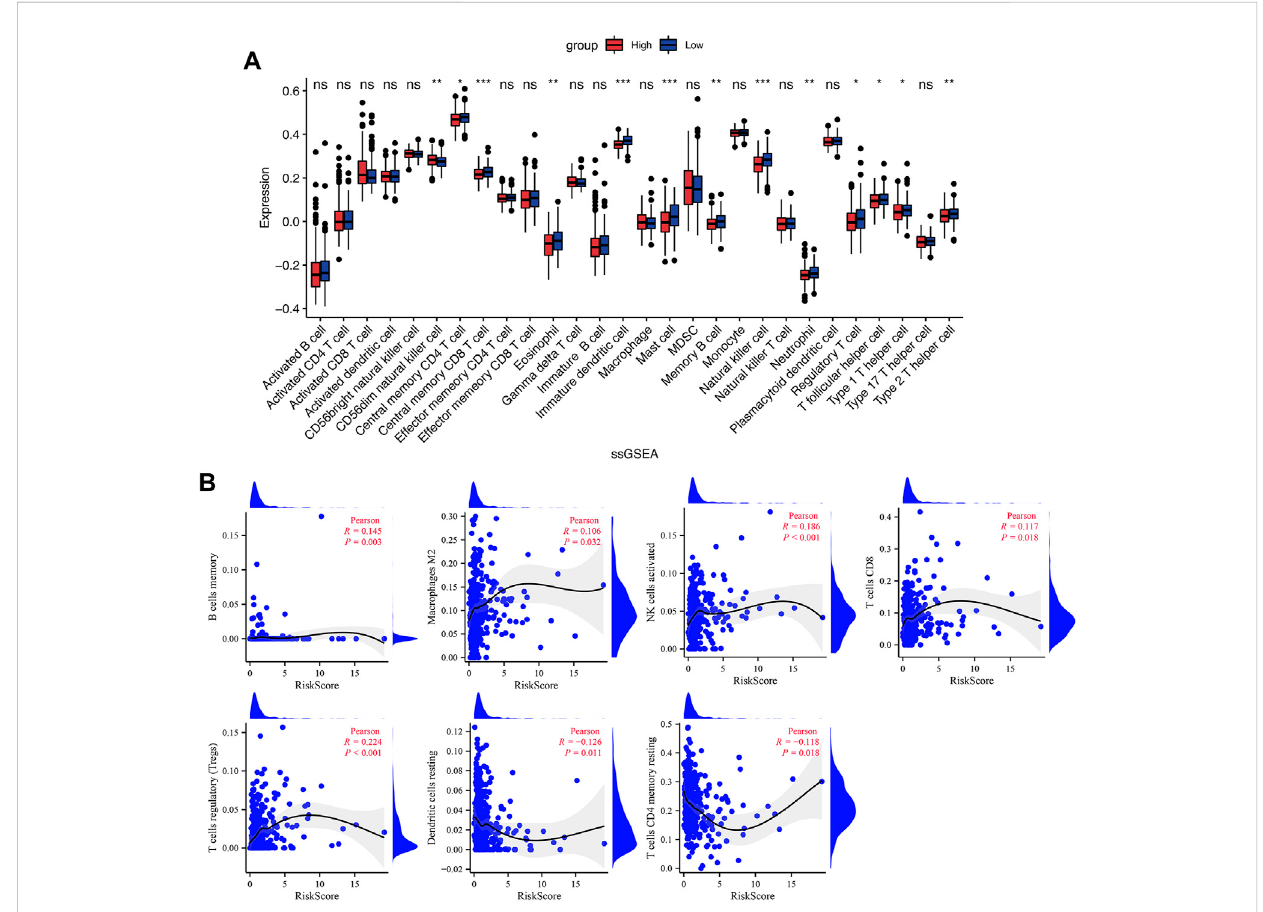
FIGURE 8 Immune cell in fi ltration in the low- and high-risk groups. (A) The in fi ltrating levels of immune cells in the low- and high-risk groups. (B) The correlation between risk score and immune cell subtype in fi ltration. * p < 0.05; ** p < 0.01; *** p < 0.001; ns, no signi fi